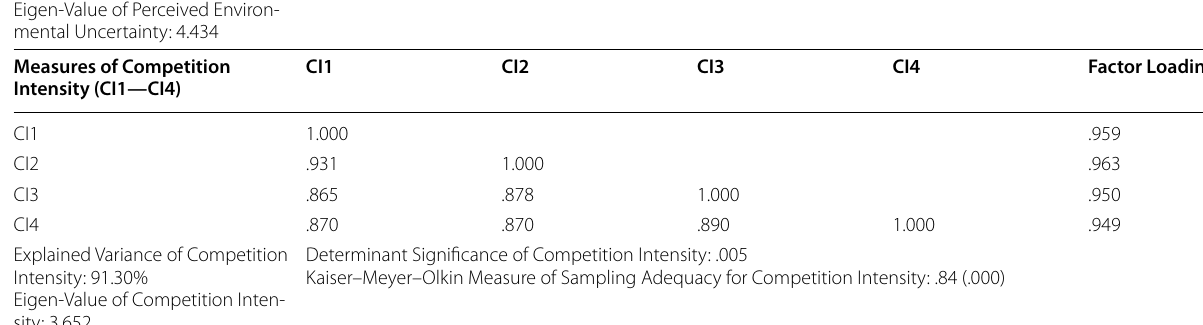
Explained Variance of Competition Intensity: 91.30% Eigen-Value of Competition Inten- sity: